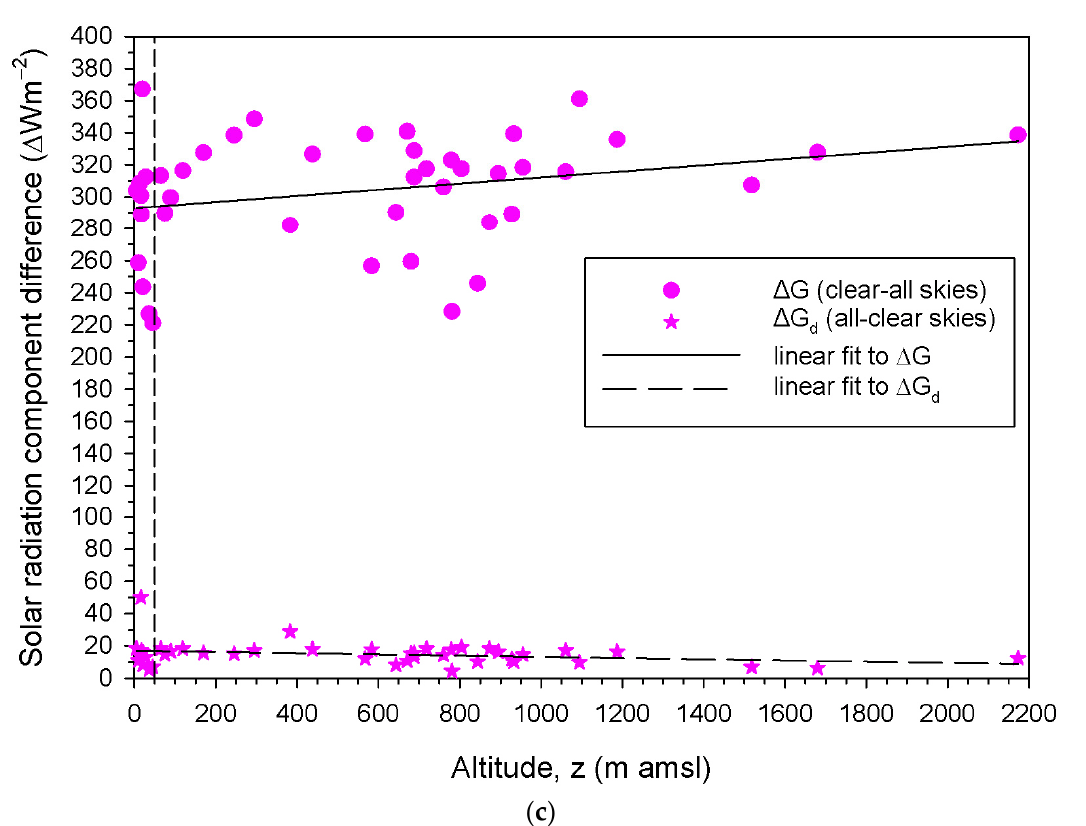
Figure 9. Variation of the annual mean values of G (circles) and G d (stars) as a function of the altitude of the sites, z (m amsl), under ( a ) all- and ( b ) clear-sky conditions; ( c ) variation in the annual mean di ff erence values of Δ G = G clear skies – G all skies (circles) and of Δ G d = G d,all skies – G d,clear skies (stars) as a function of the sites’ altitude, z (m amsl). All data points refer to the 43 sites in Saudi Arabia and the period 2013 – 2021. The vertical black dashed lines denote the altitude of 50 m amsl, a modi fi cation of the suggestion of 25 m amsl in [20]. The linear regression equations are: ( a ) G = 0.0218z + 446.8860 with RMSE = 17.0066 Wm − 2 , MAE = 12.5629 Wm − 2 , d = 0.6250, r = 0.5425, and R 2 = 0.2943; G d = − 0.0016z + 167.4120, with RMSE = 20.3609 Wm − 2 , MAE = 16.1451 Wm − 2 , d = 0.0060, r = 0.0398, and R 2 = 0.0016; ( b ) G = 0.0410z + 739.95150, with RMSE = 35.5943 Wm − 2 , MAE = 29.3567 Wm − 2 , d = 0.5730, r = 0.5010, and R 2 = 0.2510; G d = 0.0022z + 150.4645 with RMSE = 16.9010 Wm − 2 , MAE = 13.7971 Wm − 2 , d = 0.0170, r = 0.0643, and R 2 = 0.0041; and ( c ) Δ G = 0.0191z + 293.0655, with RMSE = 34.1124 Wm − 2 , MAE = 26.4212 Wm − 2 , d = 0.2410, r = 0.2715, and R 2 = 0.0737; Δ G d = − 0.0038z + 17.0474, with RMSE = 6.8780 Wm − 2 , MAE = 4.2940 Wm − 2 , d = 0.2350, r = 0.2662, and R 2 = 0.0709. The plots were made with the SYSTAT’s SigmaPlot 14.0.0.124 graphing software, and the statistical results were computed with the MICROSOFT’s Excel 2021 functions.